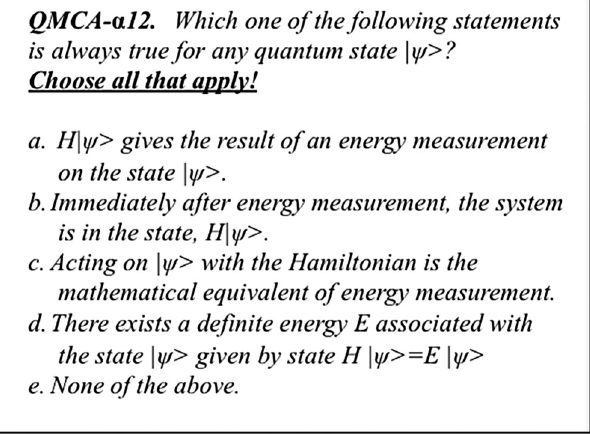
FIG. 4. QMCA − α 12 and its distractors are motivated by QMAT4 and student responses to that